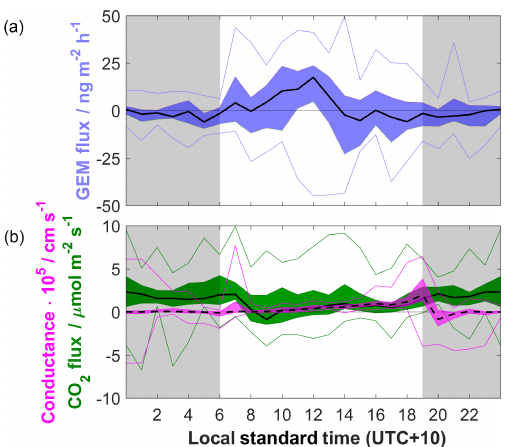
Figure 4. (a) Diel composite of GEM flux values. Black line rep- resents median values, blue shading inter-quartile range (IQR), and blue lines 5th and 95th percentiles. Grey shading represents noctur- nal periods. (b) As above for CO 2 fluxes (solid black line, green shading) and bulk canopy conductance for water vapour (broken black line, magenta